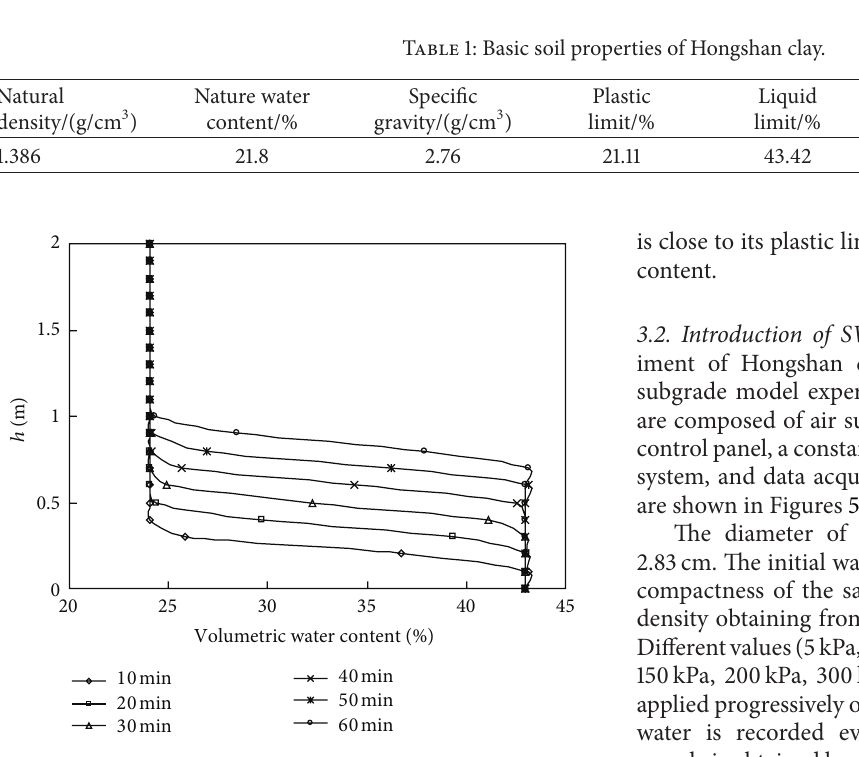
Figure 2: Variation of subgrade moisture in the rising course of groundwater table.